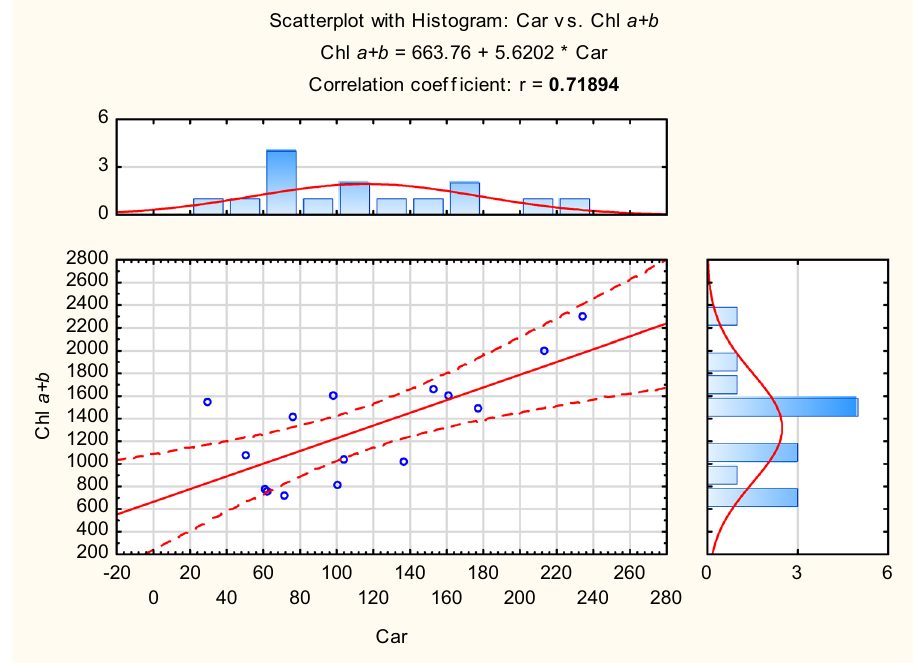
Figure 6. Scattering plot with histogram for correlation between carotenoids and chlorophyll a + b .